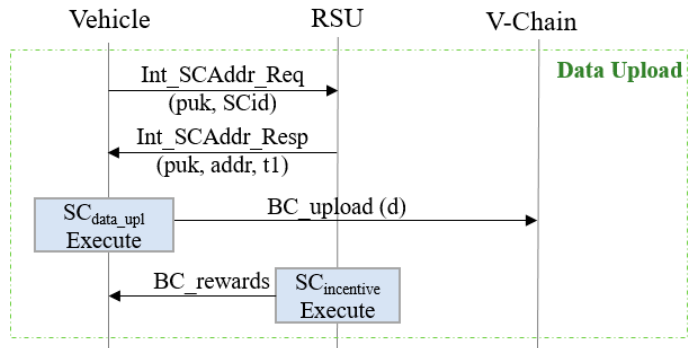
Figure 3. Vehicles upload data to the V-chain.